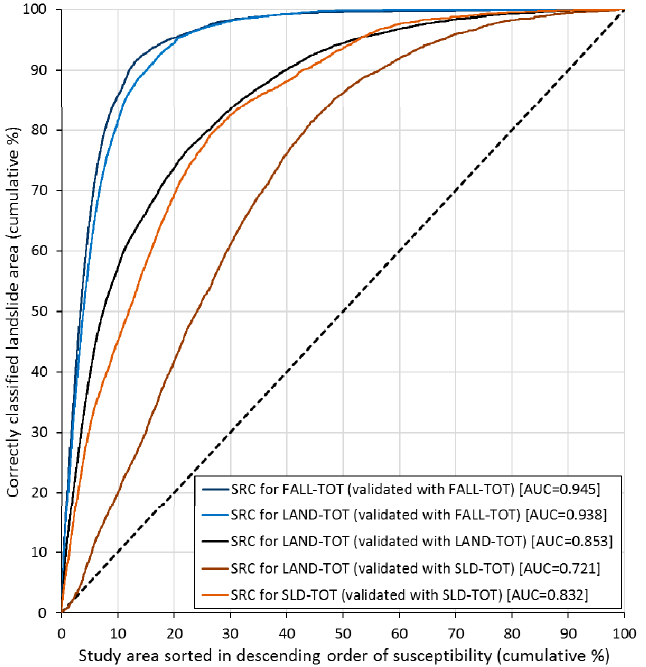
Figure 4. Success Rate Curves (SRCs) and their Areas Under the Curve (AUCs) for the different